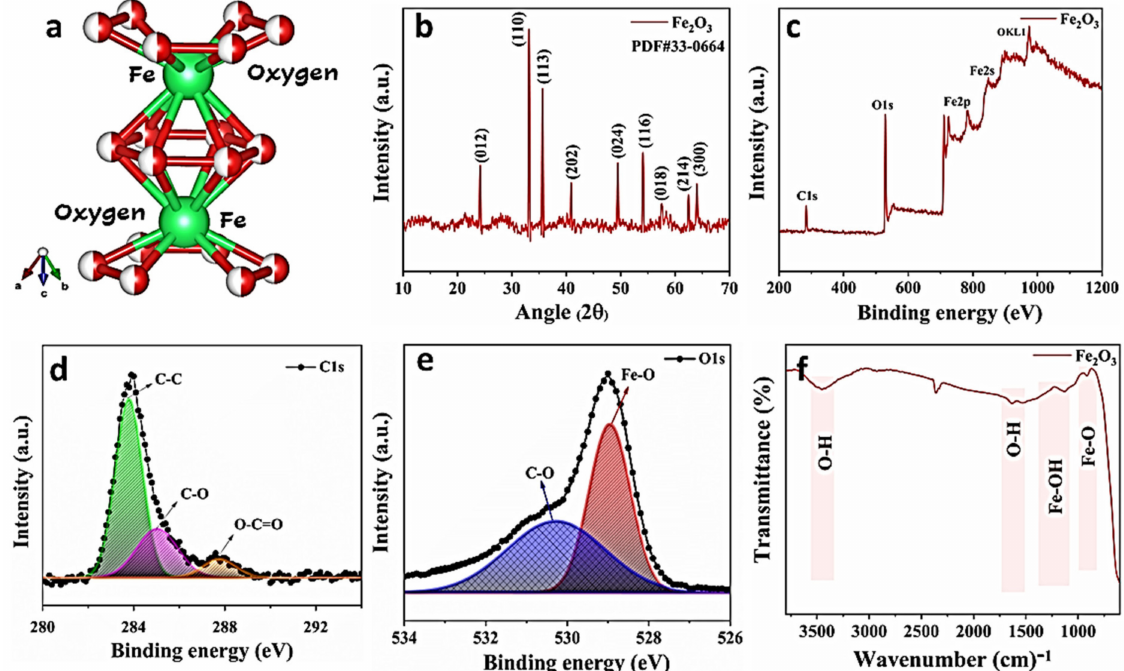
Figure 2. ( a – f ) Crystal structure and chemical states as-synthesized Fe 2 O 3 nanoparticles (NPs); ( a ) crystallographic unit cell of Fe 2 O 3 ; ( b ) XRD spectra of Fe 2 O 3 NPs; ( c ) XPS survey of Fe 2 O 3 NPs; ( d ) C 1s spectrum; ( e ) O 1s spectra of Fe 2 O 3 NPs; ( f ) FTIR stretching bonds peaks of Fe 2 O 3